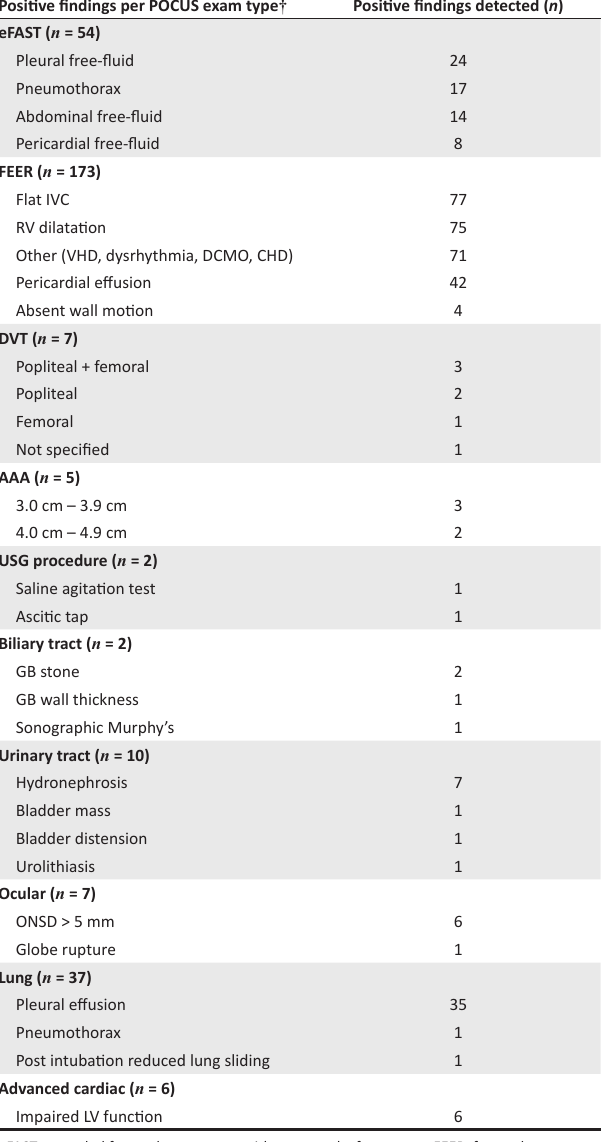
TABLE 1: Positive findings detected on point-of-care ultrasound listed by examination type.